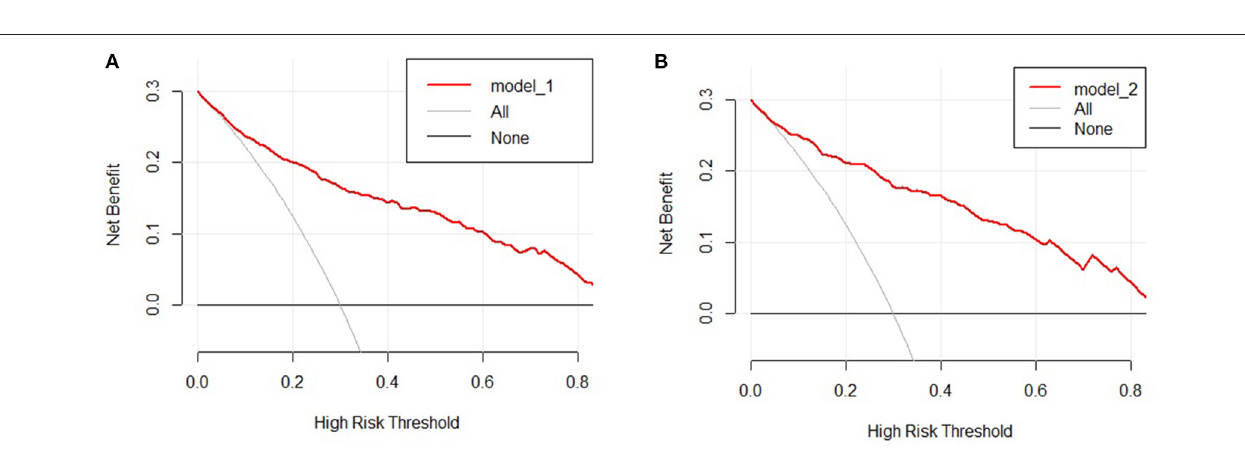
FIGURE 7 | Decision curve analysis of the nomogram in the training (A) and validation cohorts (B) . The y-axis stands the net